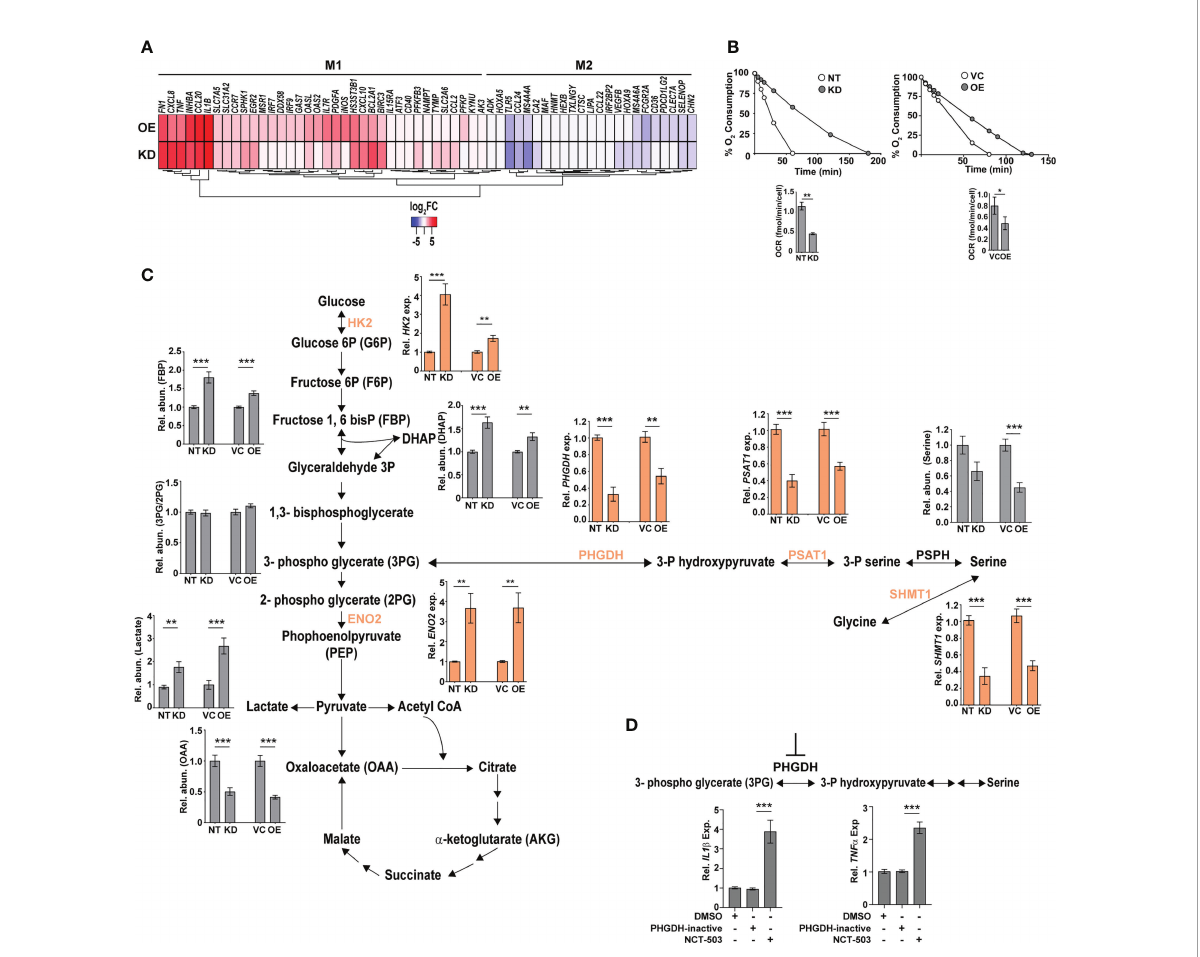
FIGURE 5 Macrophages with dysregulated CMPK2 are metabolically similar to activated M1 macrophages with higher glycolytic fl ux. (A) The expression patterns of genes speci fi c to M1 and M2 activated macrophages in the CMPK2 dysregulated macrophages KD and OE are represented as heat maps. The values represent log 2 fold change from the corresponding control cells. (B) Continual estimation of oxygen consumption in NT, KD, and VC, OE macrophages until 3 h with Oroboros oxygraph. The level of oxygen consumption was calculated, and mean OCR ± SEM of N = 3 experiments is shown. (C) Metabolite levels in the CMPK2 silenced (KD) and overexpression (OE) and their respective control macrophages were assayed from cellular extracts by MS. The levels of individual metabolites in the KD and OE macrophages are represented as relative abundance compared to control cells as mean ± SEM from three independent experiments (N = 3). Expression of genes involved in the glycolysis and serine-to-glycine biosynthetic pathway estimated by qRT-PCR is also shown. (D) Expression of IL1 b and TNF a in THP1 cells treated with